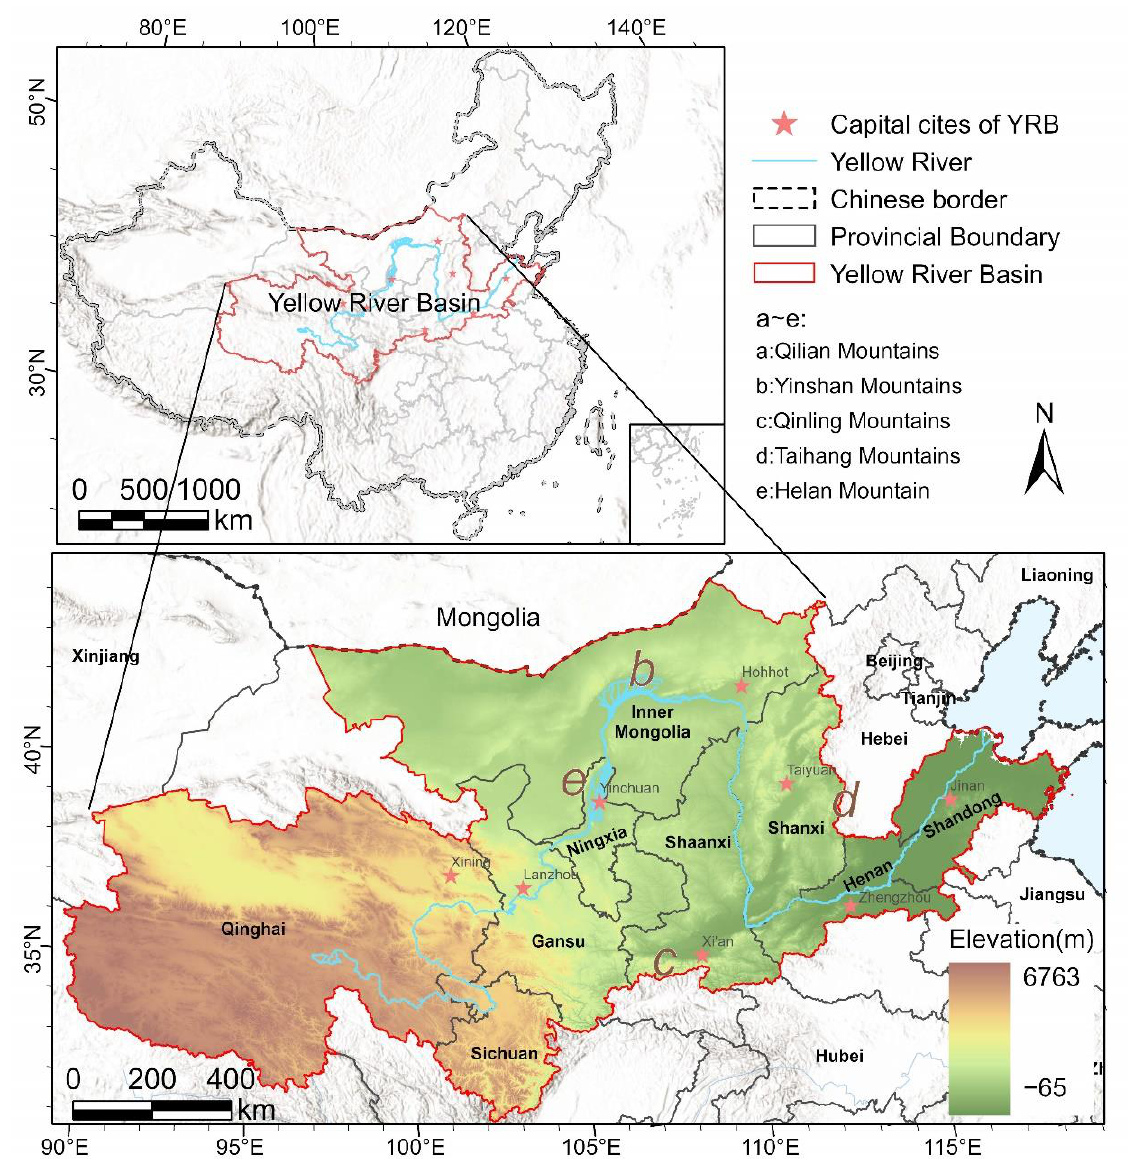
Figure 1. Location and topography of the YRB, China.